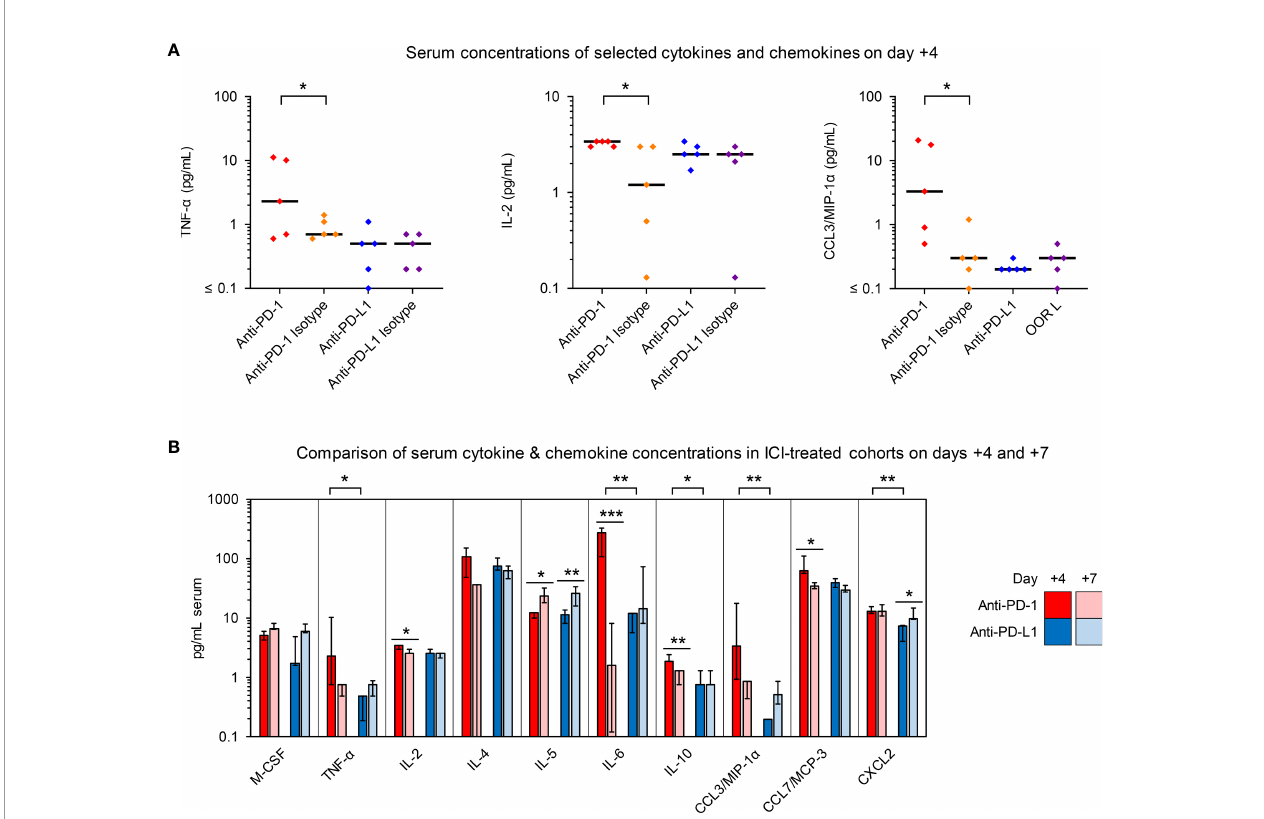
FIGURE 4 | Anti-PD-1- and anti-PD-L1-treated R. arrhizus -infected mice display disparate serum kinetics of proin fl ammatory cytokine and chemokine concentrations. Cytokine and chemokine concentrations in serum samples from R. arrhizus -infected mice receiving ICIs or isotype antibodies were quanti fi ed using a 19-plex Luminex assay. Raw data are shown in Figure S4 (day +4) and Figure S5 (day +7). (A) Individual and median concentrations of selected cytokines and chemokines per mL of serum on day +4 (n = 5 mice per treatment arm). (B) Comparison of median serum concentrations in anti-PD-1- and anti-PD-L1-treated mice on days +4 (n = 5 mice per treatment arm) and +7 (n = 6-9 mice per treatment arm). Error bars represent inter-quartile ranges. (A, B) The two-sided Mann-Whitney U test with Benjamini- Hochberg adjustment for a false discovery rate of 0.2 was used for signi fi cance testing. * p< 0.05, ** p < 0.01, *** p < 0.001. C(X)CL, C(-X)-C Motive chemokine receptor ligand; IL, Interleukin; MCP, Monocyte Chemoattractant Protein; M-CSF, Macrophage Colony-Stimulating Factor; MIP, Macrophage In fl ammatory Proteins; TNF, Tumor Necrosis